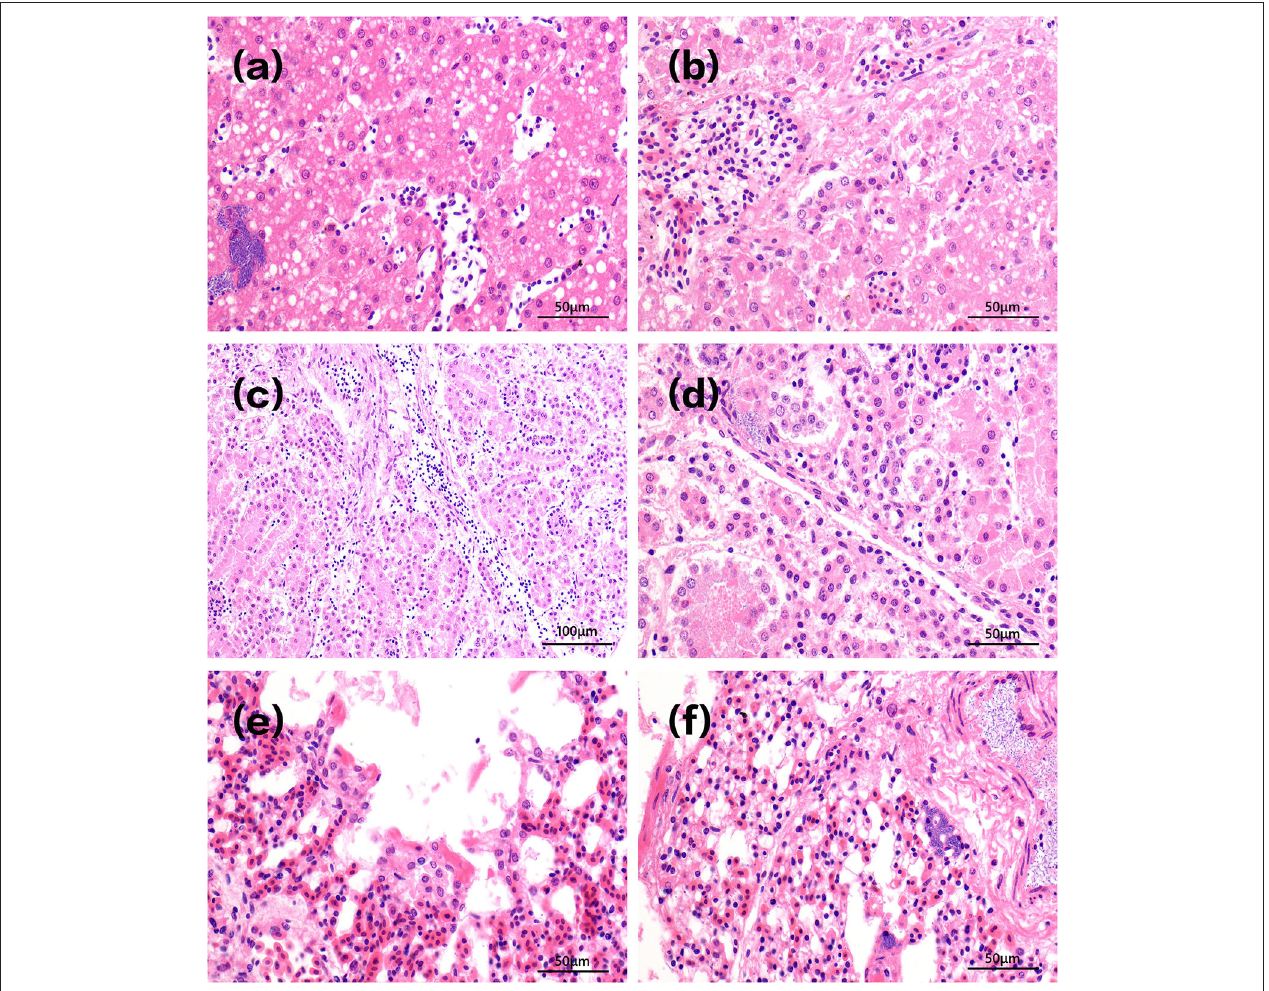
FIGURE 4 | Pathological changes of tissues in infected dead chicks. Pathological changes of chick liver in acute A1 group are shown in (a,b). The vacuoles in (a) were small in size, indicating that steatosis of liver cells was less severe. There is also a field of view of vacuolar degeneration of hepatocytes showed in (b) , in which the cellular matrix loosened and became an unstructured cystic space. Pathological changes of kidney in infected dead chicks were shown in (c,d) . (c) Inflammatory cells infiltrate chicken kidneys. (d) The epithelial cells of renal tubules were swollen and their structures were blurred, bacterial accumulation. Pathological changes of the lung at different stages of infection were shown in (e,f) . (e) Pulmonary capillary hyperemia, bacterial accumulation. (f) Alveolar serous fluid oozes out and alveolar epithelial cells proliferate and vacuoles appear in the